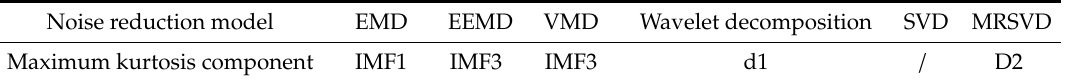
Table 6. Component selection for maximum kurtosis of various noise reduction models.